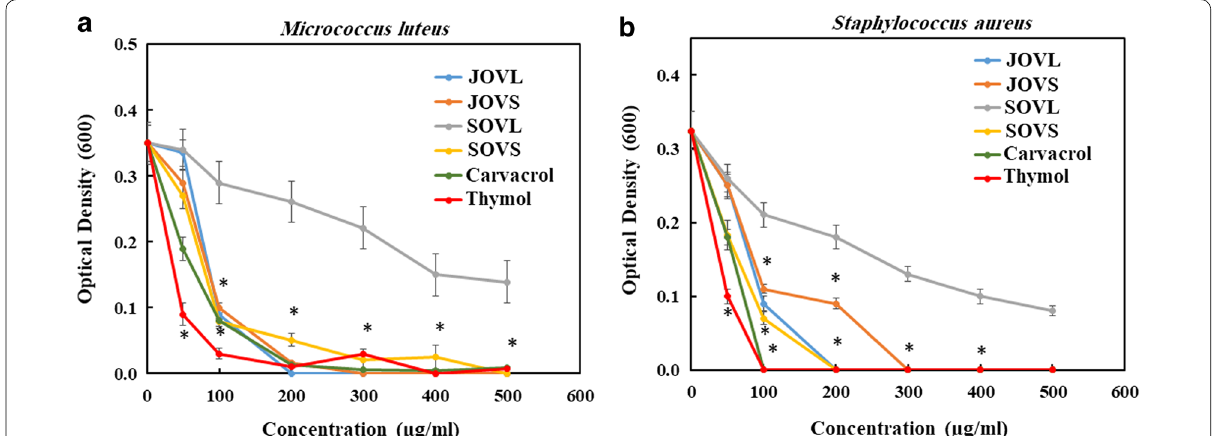
Fig. 5 Growth inhibition of Gram-positive bacteria ( M. luteus ( a ) and S. aureus ( b )), as measured by the change in OD 600 following treatment with different samples. Asterisk indicates the values that are significantly different from the control ( p value <